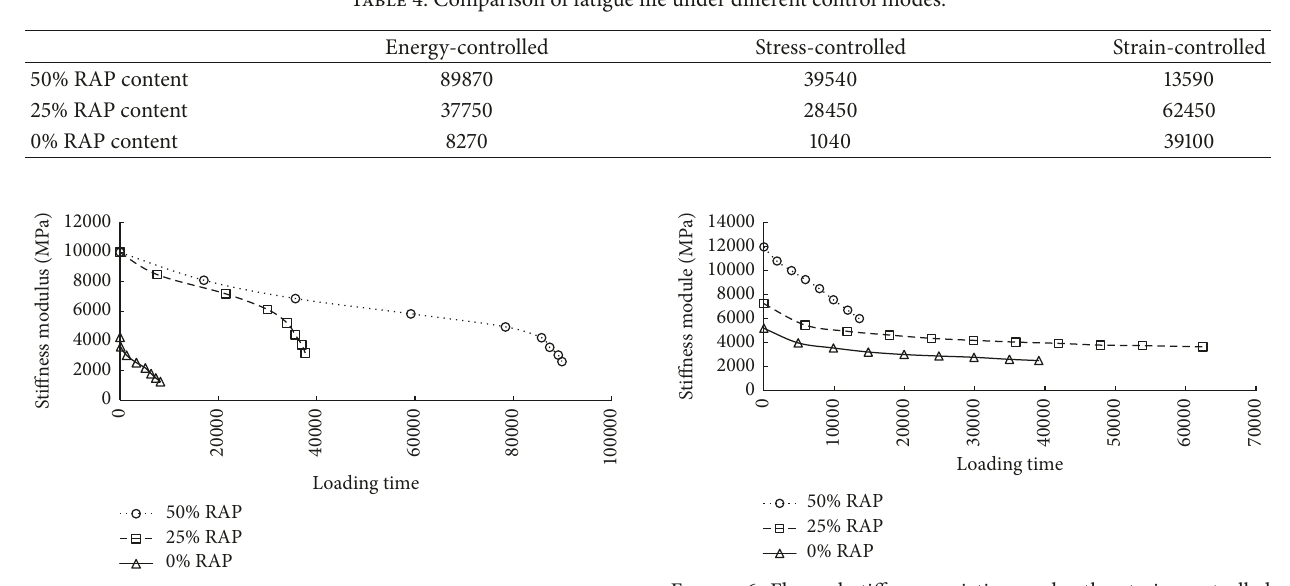
Figure 4: Flexural stiffness variation under the energy-controlled mode at 15 ∘ C.